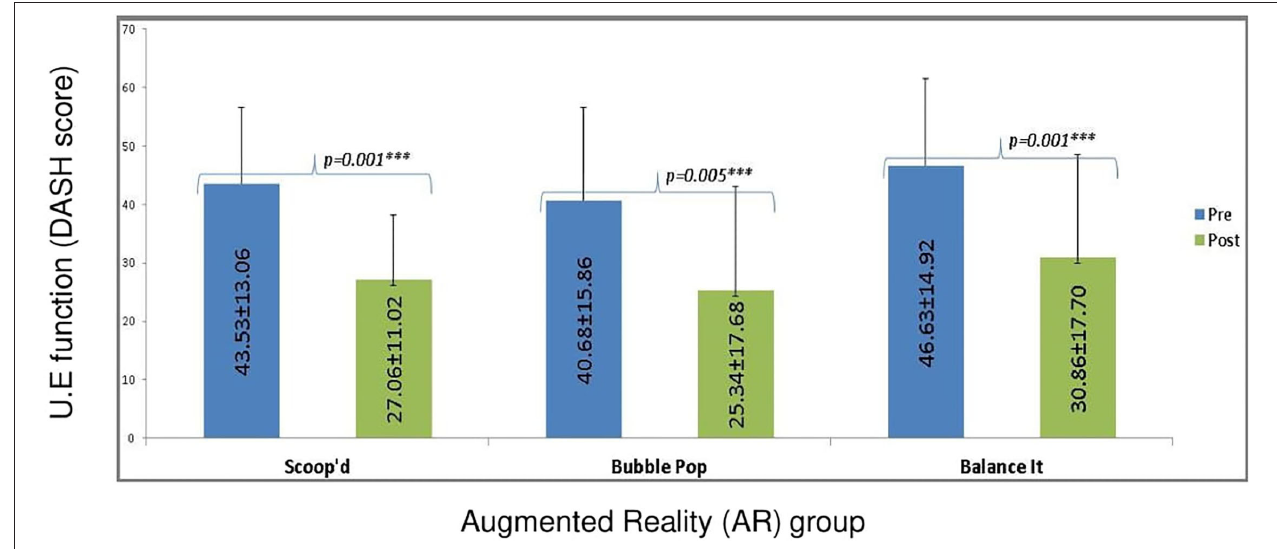
FIGURE 6 | Pre- and Post-intervention analysis of DASH (with-in-groups). The *** symbol indicates the values which are statistically